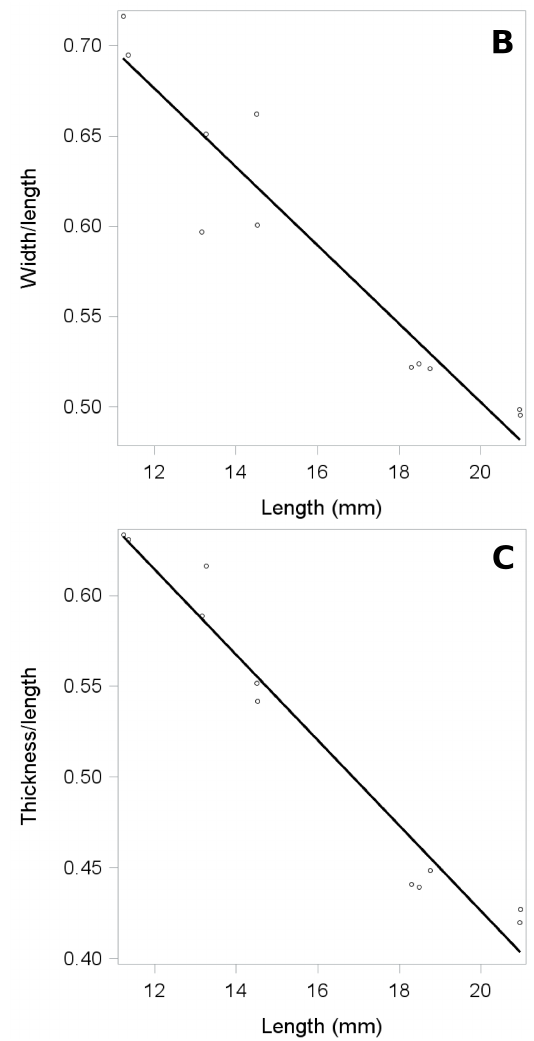
Figure 5. Estimated ( A ) kernel length predicted by 100 sound mature kernel (SMK) wt and ( B ) width and ( C ) thickness aspect ratios predicted by kernel length. Respective slope and intercept parameter estimates, corresponding p values, and model robust R 2 were: ( A ) 0.131, 7.982, <0.001, <0.001, and 0.809, ( B ) − 0.0217, 0.937, <0.001, <0.001, and 0.828, and ( C ) − 0.0235, 0.897, <0.001, <0.001, and